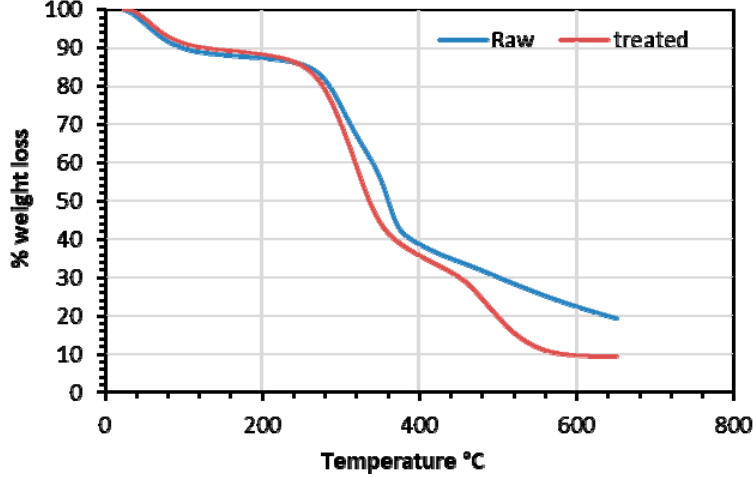
Figure 7. TGA (thermogravimetric analysis) thermographs of raw and mechanically pretreated barley.